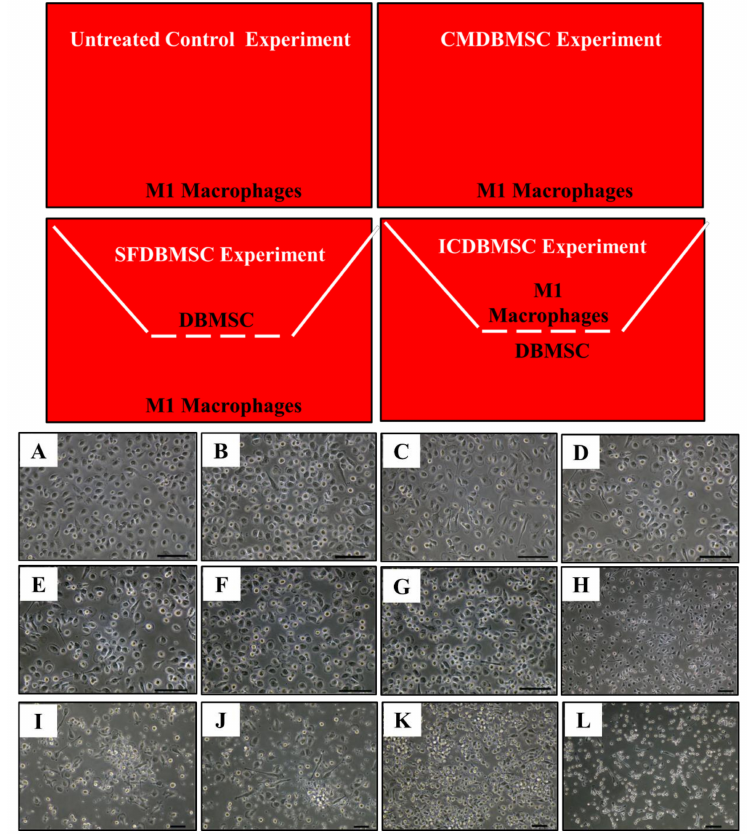
Figure 1. M1 macrophage culture system. Untreated control experiment consisted of M1 macrophages cultured on a surface of 6-well culture plate in a medium containing GM-CSF, CMDBMSC experiment consisted of M1 macrophages cultured on a surface of 6-well culture plate in a medium containing GM-CSF and CMDBMSC (conditioned medium), SFDBMSC (soluble factor), and ICDBMSC (intercellular direct contact) experiments. In SFDBMSC and ICDBMSC experiment, cells (DBMSCs and monocytes) were separated by transwell chamber membrane culture system. For the experiments of SFDBMSC, DBMSCs were seeded on the upper compartments while monocytes were seeded in the lower compartment. For the experiments of ICDBMSC, DBMSCs were seeded on the reverse side of the membrane while monocytes were seeded on the upper side of the membrane. GM-CSF medium was added to SFDBMSC and ICDBMSC experiments. Effects of human DBMSCs on the morphology of human monocytes differentiated into macrophages by GM-CSF. ( A – F ) Represent phase-contrast microscopic images showing monocyte (round-shaped morphology) differentiation into M1-like macrophages (fried egg-shaped morphology) after six days of culture in a medium containing GM-CSF ( A ), in a medium containing GM-CSF and DBMSCs at a 20:1 monocyte: DBMSC ratio ( B ), at a 10:1 monocyte: DBMSC ratio ( C ), at a 1:1 monocyte: DBMSC ratio ( D ), in the presence of 10% CMDBMSC ( E ), or in the presence of 20% CMDBMSC ( F ). ( G – K ) Representative phase-contrast microscopic images showing monocyte-like cells after six days of culture in a medium containing GM-CSF and 30% CMDBMSC ( G ), 40% CMDBMSC ( H ), 50% CMDBMSC ( I ), 60% CMDBMSC ( J ), 80% CMDBMSC ( K ), or 100% CMDBMSC ( L ). Experiments were carried out in duplicate and repeated 30 times using 30 individual preparations of both monocyte-derived macrophages and DBMSCs. Scale bars represent 50 µ